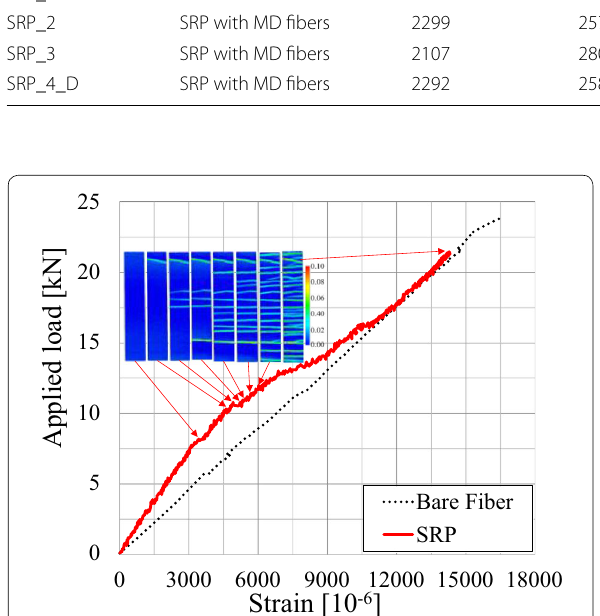
Fig. 2 Typical applied load-axial strain responses of bare steel fiber sheet and SRP plate with MD fibers